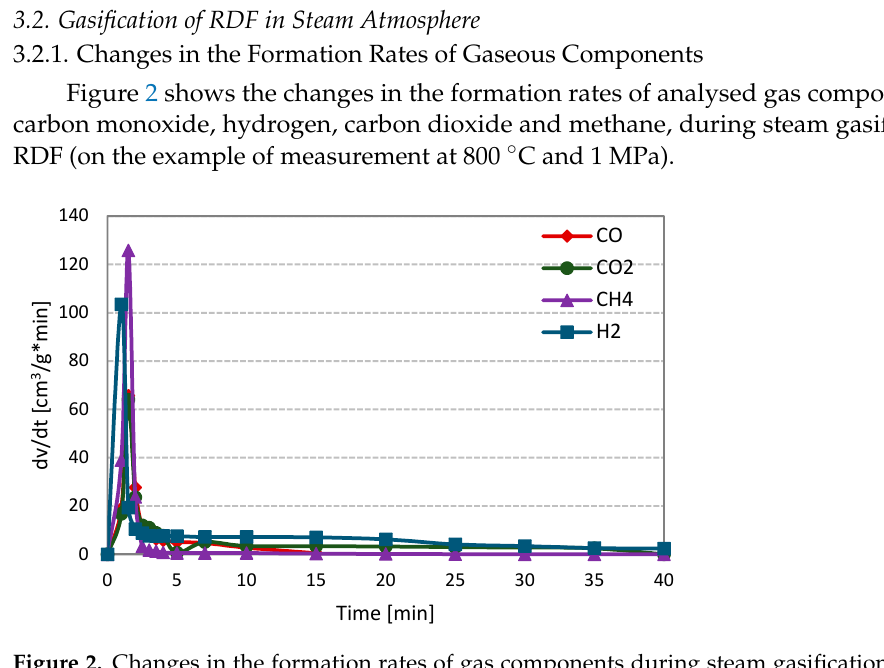
Figure 2. Changes in the formation rates of gas components during steam gasification of RDF at 800 °C and 1 MPa.